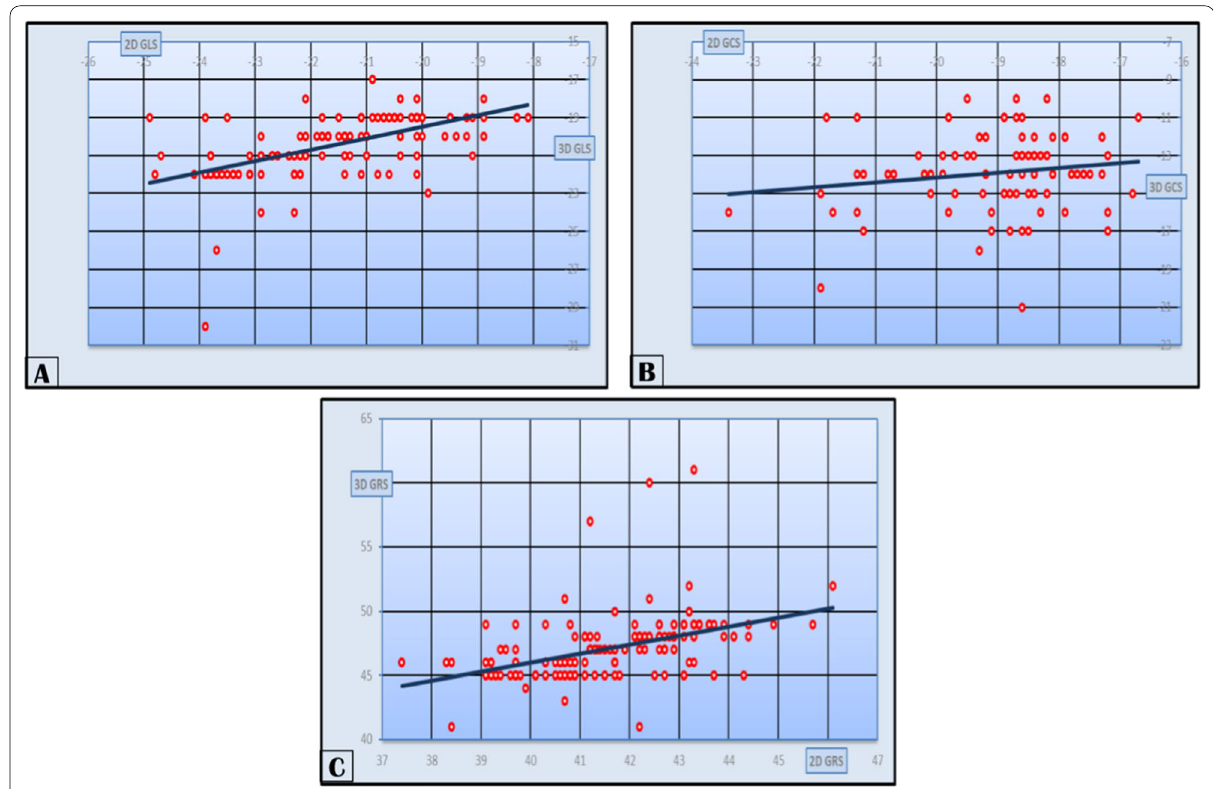
Fig. 5 Linear correlation between A 2D and 3D GLS, B 2D and 3D GCS, C 2D and 3D